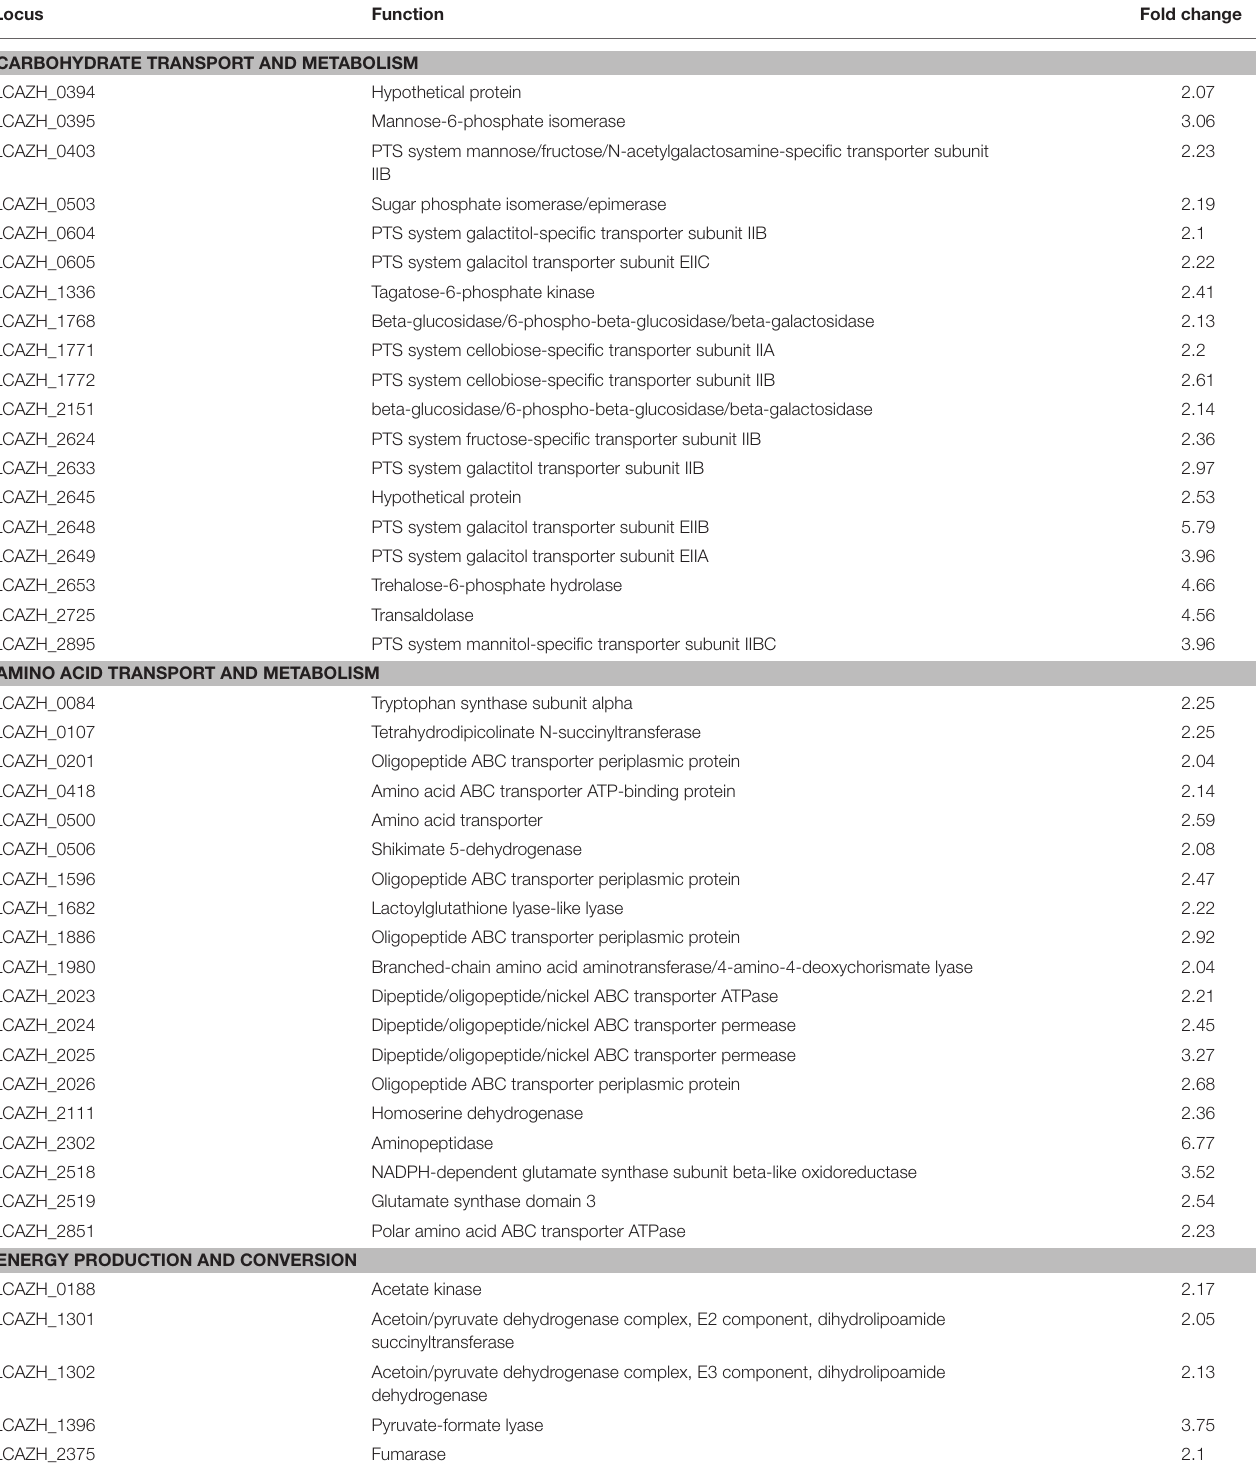
TABLE 2 | Up-regulated proteins of L. casei Zhang-G-1200 compared with its original strain in the presence of the gentamycin. Locus Function Fold change CARBOHYDRATE TRANSPORT AND